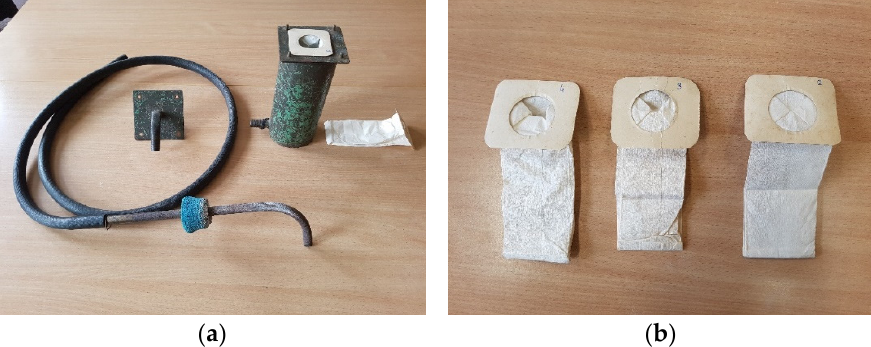
Figure 3. Salt-dust concentration measurement points: ( a ) P1—in front of the scrubber; ( b ) P2—behind the scrubber.